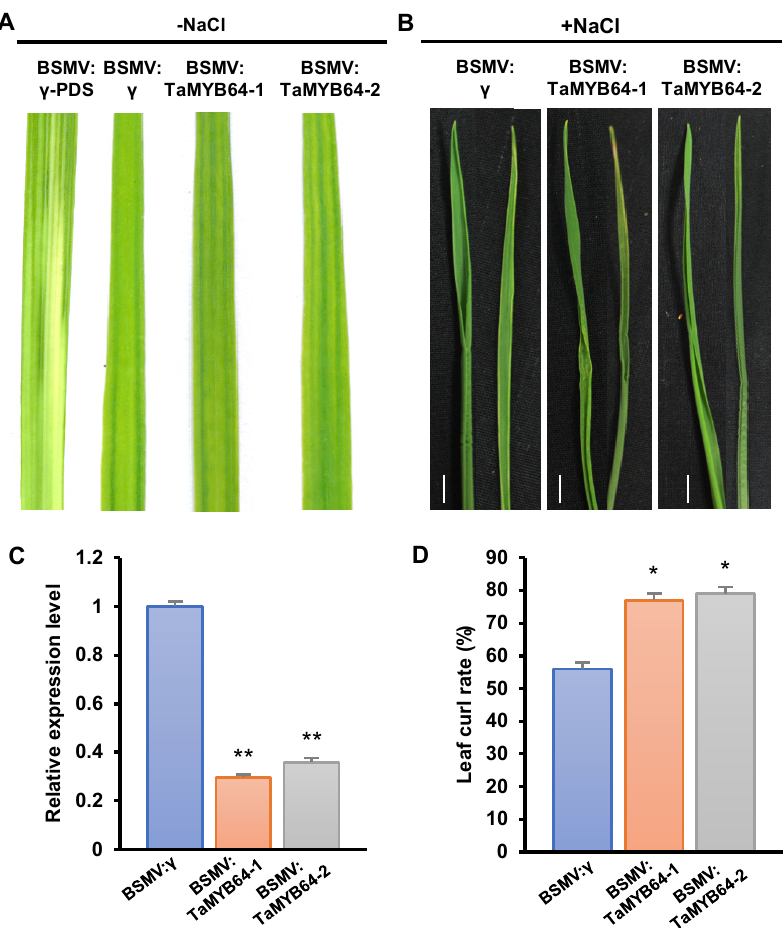
Figure 7. Silencing of TaMYB64 decreases salt tolerance in wheat. ( A ) Phenotypic characteristics of wheat leaves after TaMYB64 silenced by VIGS technology. ( B ) The curling phenotype of wheat leaves after 12 days of 300 mM NaCl treatment. Bars, 1 cm. ( C ) Silencing efficiency assessment of TaMYB64 in the TaMYB64 -knockdown plants treated with 12 days of 300 mM NaCl. ( D ) Statistics of leaf curls rate of TaMYB64 in the TaMYB64 -knockdown plants treated with 12 days of 300 mM NaCl. Error bars represent the SD of three biological replicates. The asterisks indicate statistical significance using Student’s t -tests. (**, p < 0.01; *, p <